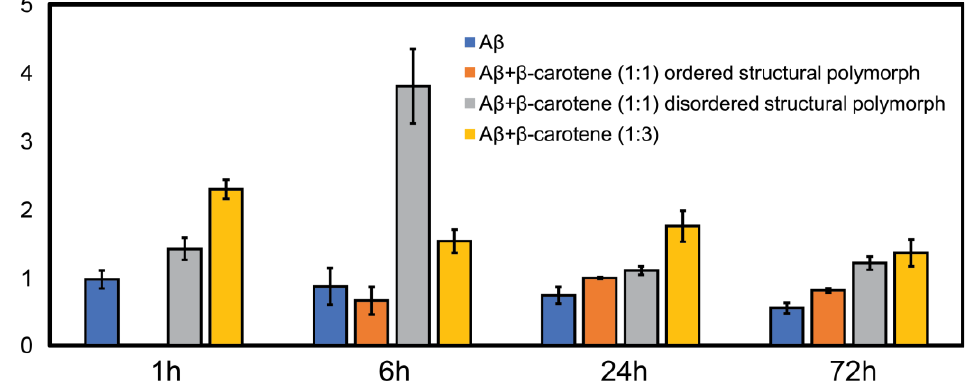
Figure 5. Ratio of intensity of amide I band at 1666 cm −1 to that at 1636 cm −1 at different time-points during aggregation. Higher value of ratio indicates relative increase in non-beta sheet/disordered structure. The data point for ordered polymorph at 1 h is missing, since no such aggregates were found. The ratios were calculated for each of the spectra shown in Figures 1 – 4, and mean values are shown here. Error bars denote the standard deviation.